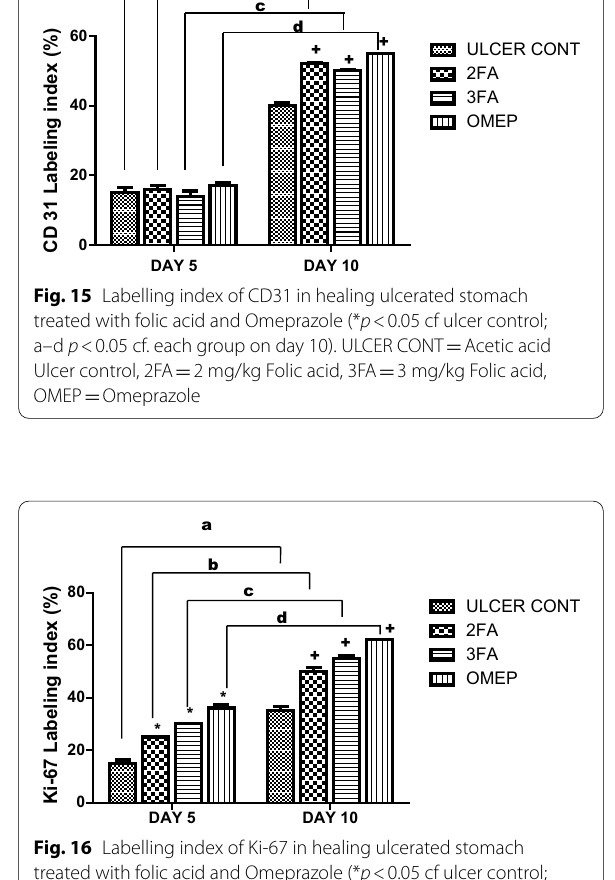
Acetic acid = 3 mg/kg Folic acid, =